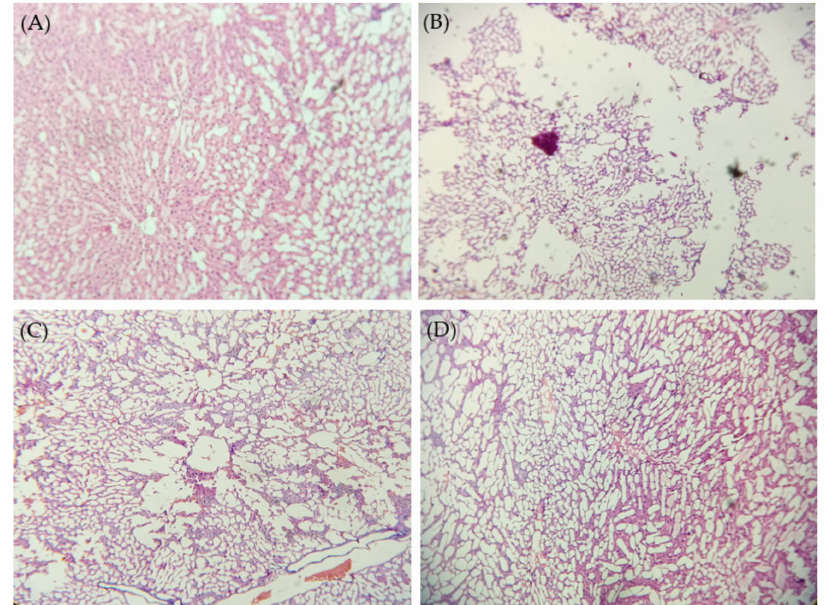
Figure 8. Histological micrographs of liver tissue of ( A ) negative control (treated with Tween 20 (1% v / v ); ( B ) CCl 4 -intoxicated rats (treated with CCl 4 + olive oil (1:1.5 mL/kg)); ( C ) CCl 4 -intoxicated rats treated with plain silymarin and ( D ) CCl 4 -intoxicated rats treated with optimized silymarin phytosomal formulation. 100 ×